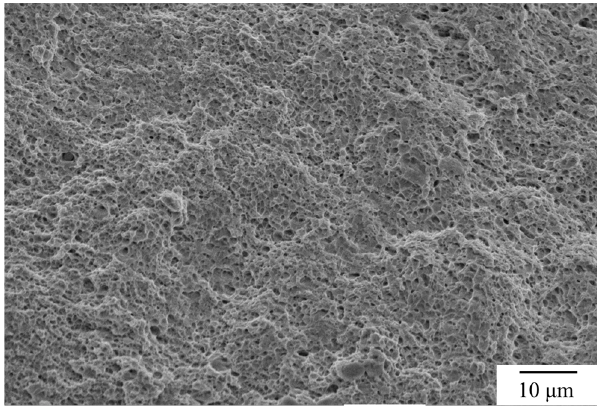
Figure 22. SEM picture of fracture surface of AISI 4340 volumes built up with EHLA.